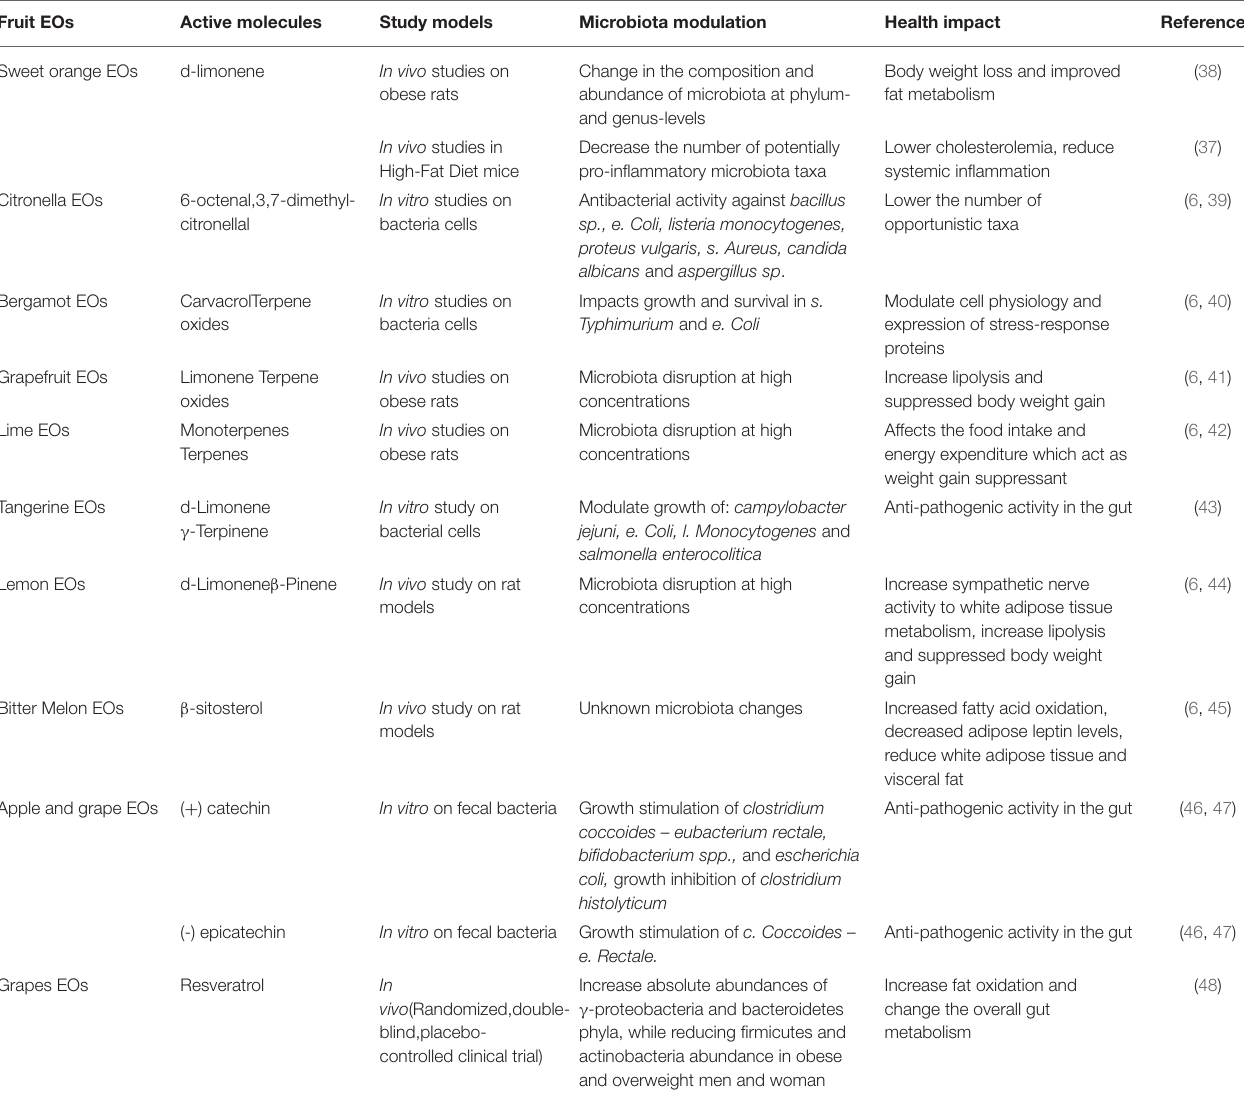
TABLE 1 | Bioactive molecules from fruit EOs with gut and microbiota modulation activity and their study models. Fruit